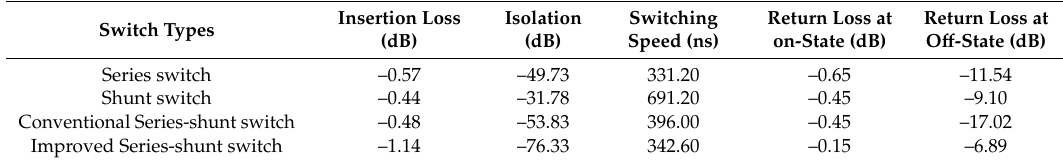
Table 4. Performance of di ff erent